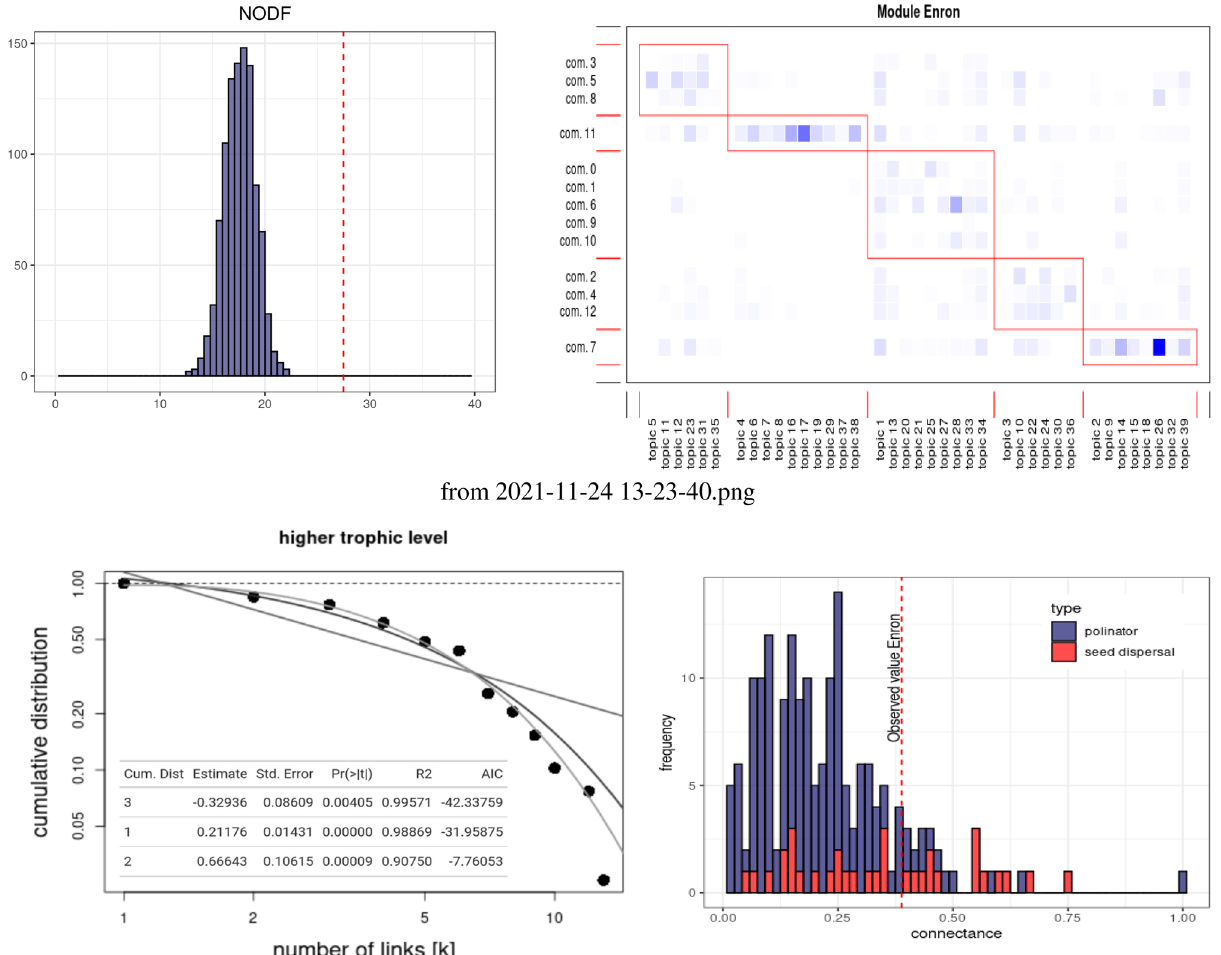
Figure 3. Summary null models. Top Left: The distribution is the output of patefield algorithm, in which we calculate the NODF value for each of the 2000 null models. The red dotted line represents the NODF value for the ENRON interaction matrix. Top-right: The matrix containing the modules in the ENRON network, as detected by the QuaBiMo algorithm 34 . Bottom left: The goodness of fit of various long-tail distributions to the ENRON degree distribution. The truncated power law is favored as indicated by the smaller AIC score. Bottom right: A comparison of observed connectance relative to true ecological